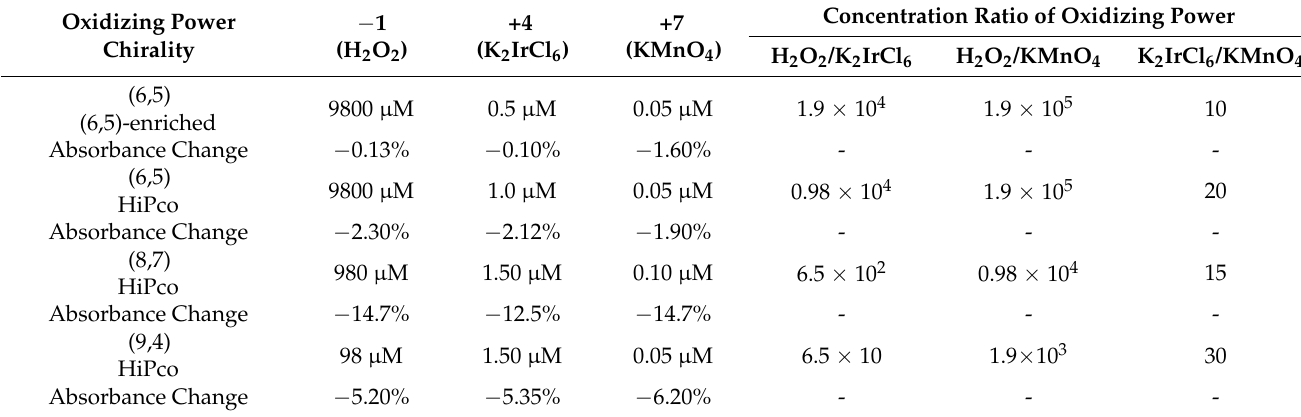
Table 1. Relationship between the oxidizing power and absorbance change for each chirality. The upper part of the chirality column shows the concentration of the added oxidant, and the lower part shows the change in absorbance at that time, relative to the initial state. The data are presented as the average of three independent